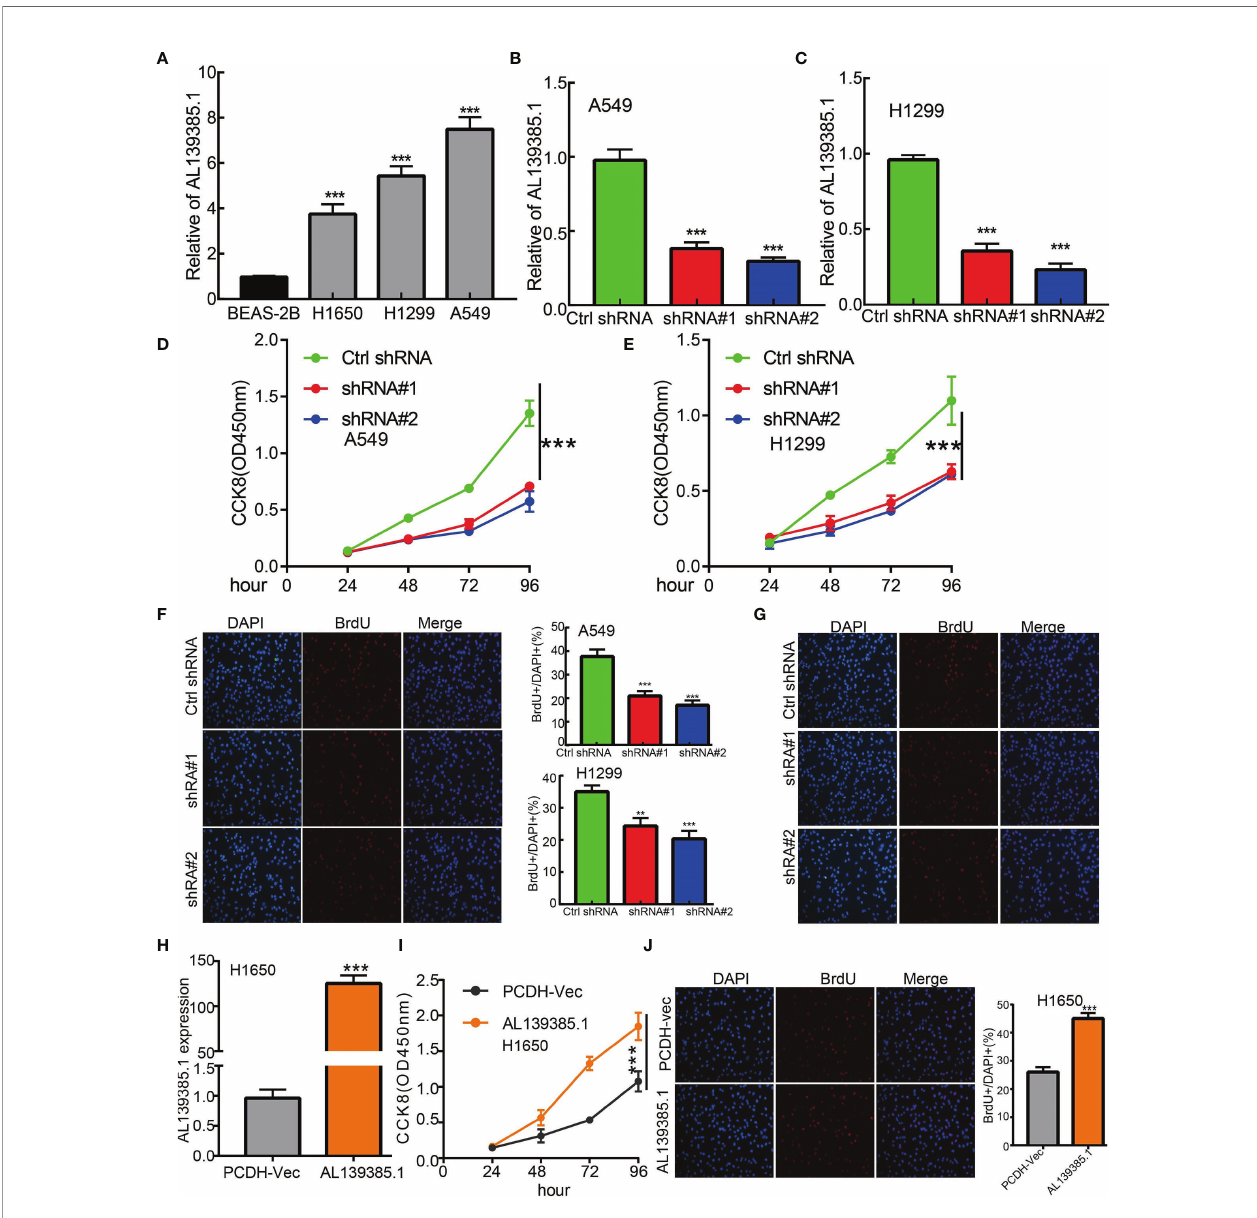
FIGURE 10 | lncRNA-AL139385.1 regulates LUAD cell proliferation in vitro. (A) The relative expression level of AL139385.1 in lung adenocarcinoma cancerous cell lines, including H1299, H1650, and A549 examined by real-time RT-PCR, compared to normal human bronchial epithelial cell line: BEAS-2B. (B, C) Establishment of AL139385.1 knockdown cell lines in A549 and H1299 veri fi ed by real-time RT-PCR assay. (D – G) Knockdown of AL139385.1 signi fi cantly inhibits cell proliferation in A549 and H1299 cells, as measured by CCK8 and BrdU incorporation assay. (H) Establishment of AL139385.1 overall cell lines in H1650 veri fi ed by real-time RT- PCR assay. (I, J) Overexpression of AL139385.1 signi fi cantly promotes cell proliferation in H1650 cells, as measured by CCK8 and BrdU incorporation assay. **P<0.01 and ***P<0.001. shRNA#1, AL139385.1 shRNA#1; shRNA#2, AL139385.1 shRNA#2; AL139385.1,